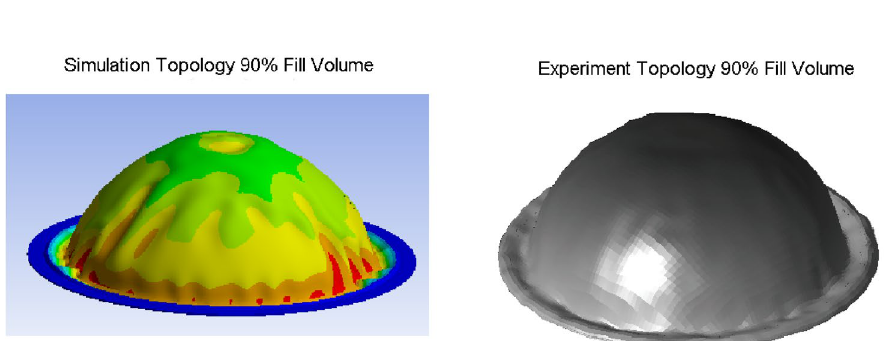
Fig. 15 Comparison between numerical simulation results and experimental scans of dia- phragm at 90% volume ratio